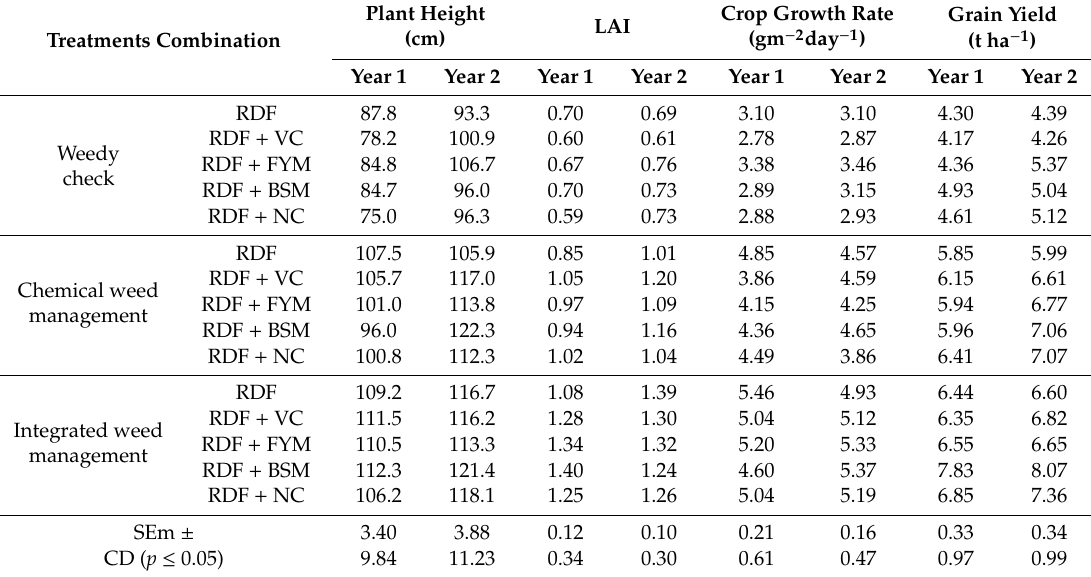
Table 5. Interaction e ff ect of di ff erent nutrient managements and weeding regimes on plant height, leaf area index (LAI) at 60 DAS, crop growth rate (CGR) at 60–90 DAS, and grain yield of hybrid maize at